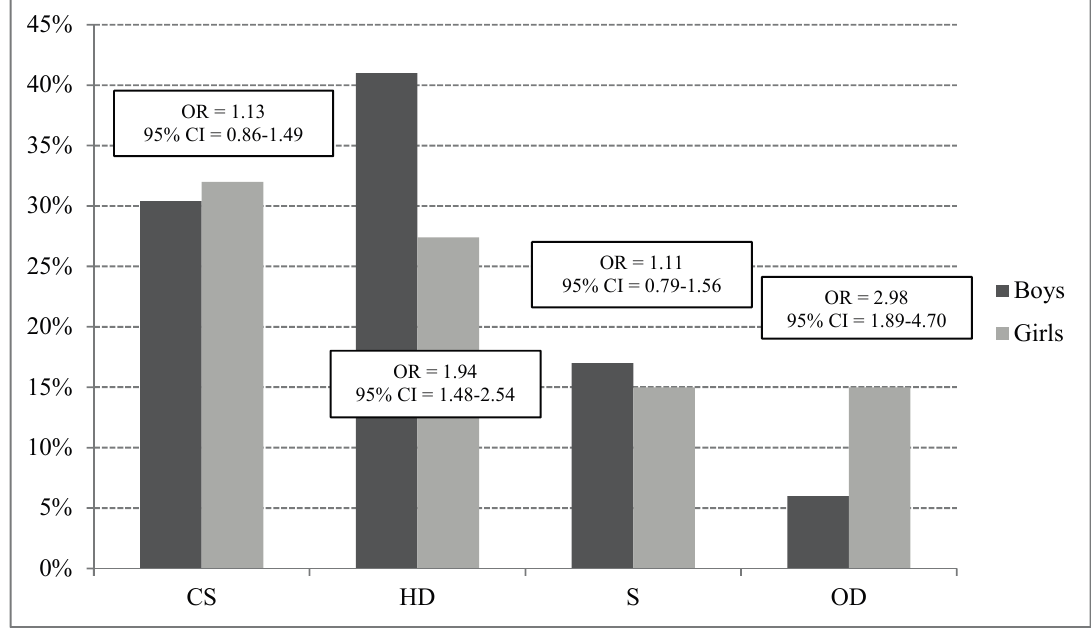
Figure 1. Comparison of cigarette smoking (CS), harmful drinking (HD), simultaneous smoking and harmful drinking (S) and consumption of other drugs (OD) by gender (OR—Odds Ratio; CI—confidence